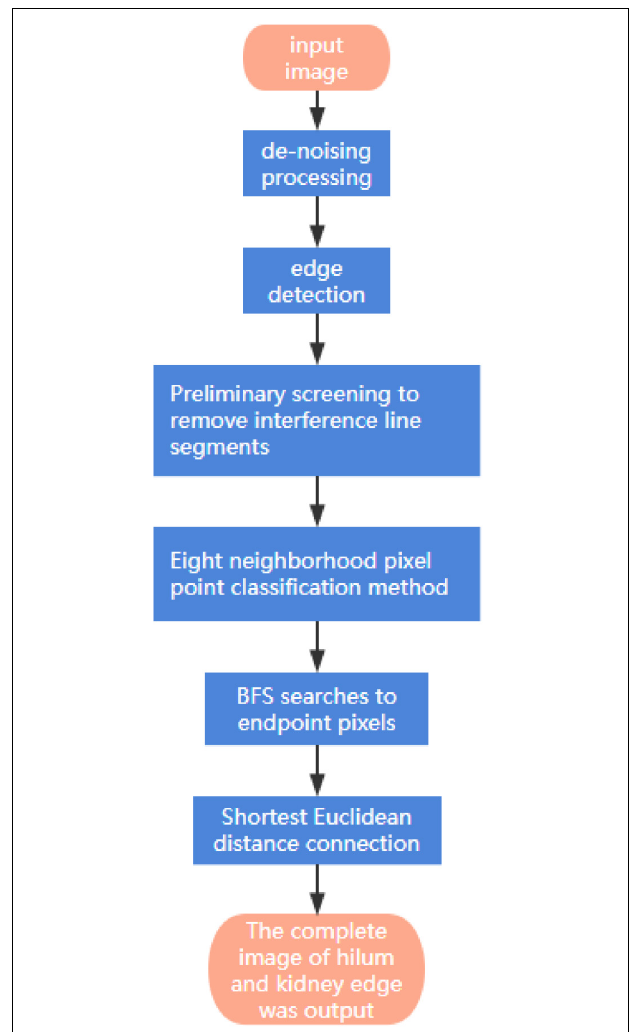
FIGURE 12 | Edge contour algorithm